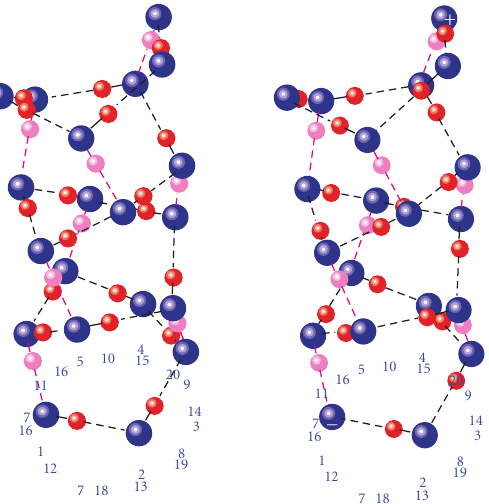
Figure 4: The dense part of water density fluctuations with the coherent exchange of protons (red balls) between oxygen atoms (blue balls) along the helical hydrogen bonds (black lines) and HB bridges (pink balls); the projections of oxygen atoms in the ( x , y ) plane are denoted by